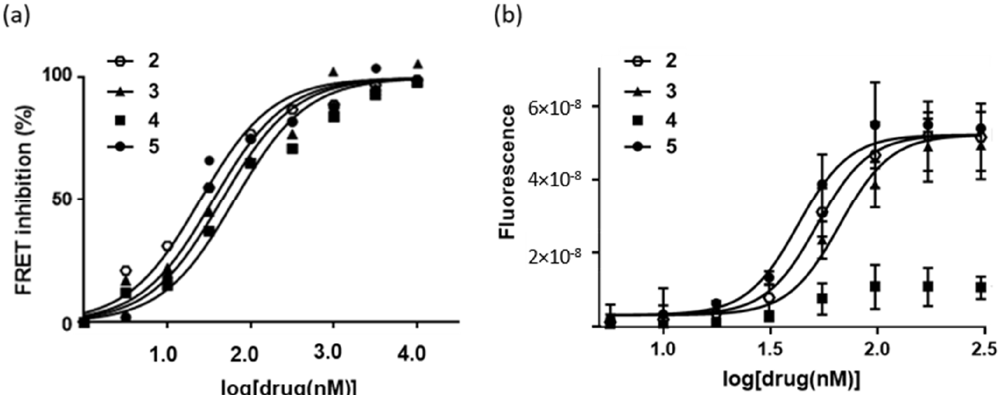
Figure 5. Cell-based assays: ( a ) FRET inhibition using a reporter cell-based assay. The dose-response curves were obtained upon addition of PD-L1 (10 µM) to co-transfected PD1-SHP2 cells, in the presence of increasing concentrations of the molecule under study. Data from five independent experiments (n = 5) were used to calculate IC 50 values using the Graphpad software. ( b ) CTLL-2 cell proliferation assay. The graphic shows the dose-dependent reactivation of the proliferation of CTLL-2 cells cultured in the presence of rhPD-L1 chimera and the PD-L1 inhibitor which blocks the PD-1/PD-L1 checkpoint so as to reactivate cell proliferation. The plots were used to determine IC 50 values with data obtained from three independent experiments (n =